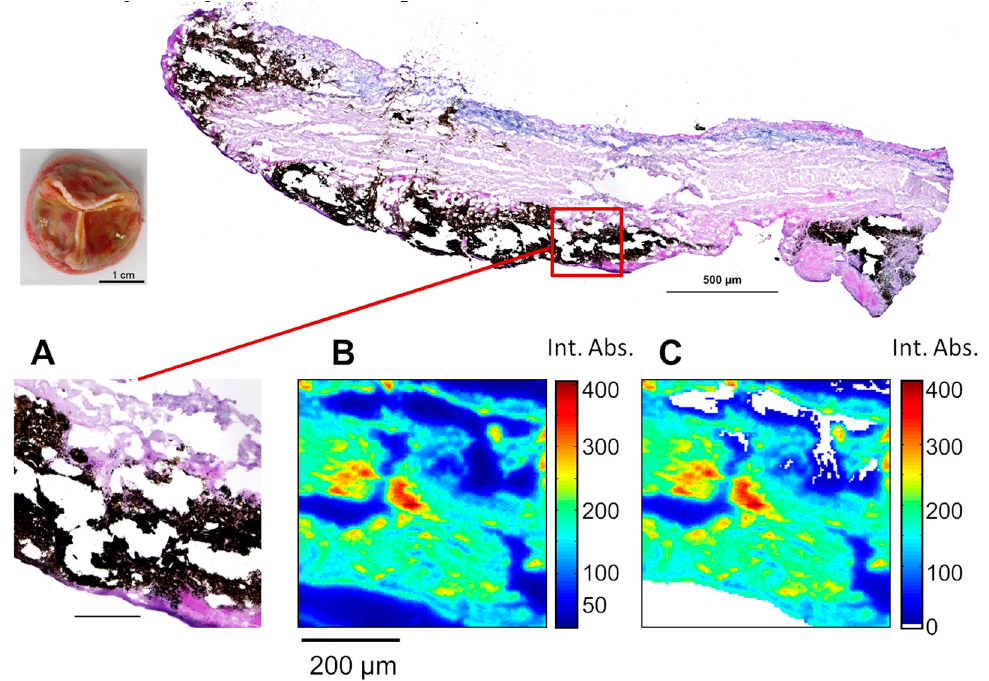
Figure 4. Von Kossa/HE staining of a calcified bioprosthesis sample with region analysed in FT- Figure 4. Von Kossa / HE staining of a calcified bioprosthesis sample with region analysed in FT-IR IR imaging. A ) calcified bioprosthesis sample and resulting histological von Kossa/HE staining“ imaging. ( A ) calcified bioprosthesis sample and resulting histological von Kossa / HE staining“ (entire (entire section in the upper panel). B ) IR spectroscopic image (brightfield image) and C ) IR section in the upper panel). ( B ) IR spectroscopic image (brightfield image) and ( C ) IR spectroscopic spectroscopic image after preprocessing. White pixels indicate outliers. image after preprocessing. White pixels indicate